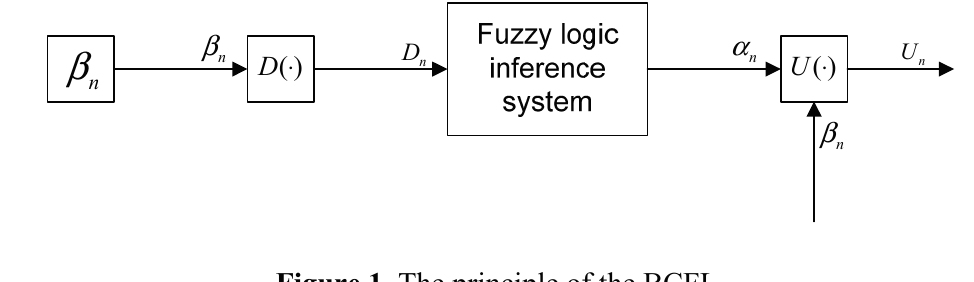
Figure 1. The principle of the